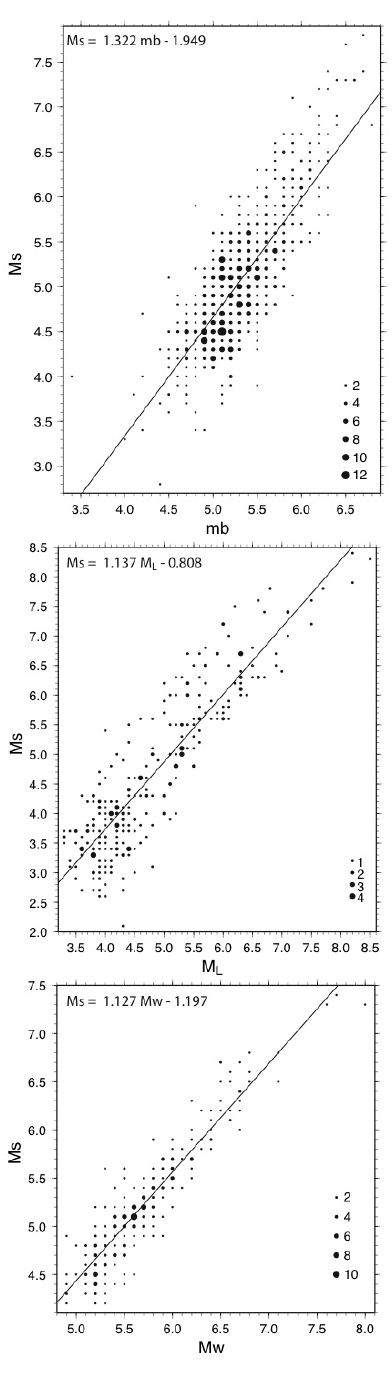
Fig. 1. Linear relation between different magnitudes, from top to Figure 1. Linear relation between different magnitudes, from top to bottom is presented Ms as bottom is presented M s as a function of mb, M L , and M w , respec- tively; continuous lines represent the least squares fits with relation a function of mb, M , and Mw, respectively; continuous lines represent the least squares fits L shown in the upper left corner. Each dot represents an observed pair, where the size is proportional to the number of observations of with relation shown in the upper right corner. Each dot represents an observed pair, where the that pair (see scale in lower right side of each plot). size is proportional to the number of observation of that pair (see scale in lower right side of each plot).